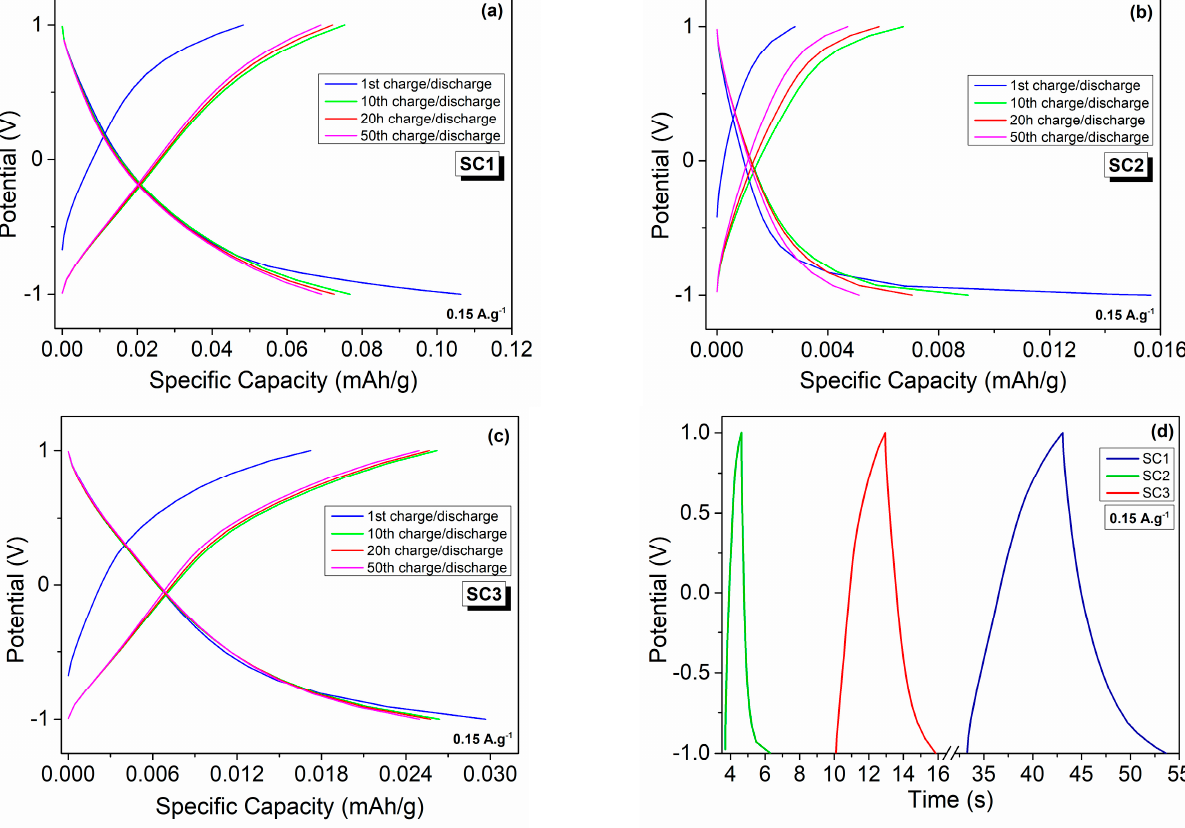
Figure 10. Galvanostatic charge–discharge profiles of the symmetric and asymmetric all-in-one SCs at a current density of 0.15 A.g − 1 : 1st, 10th, 20th, and 50th charge–discharge cycles of ( a ) SC1, ( b ) SC2, and ( c ) SC3; ( d ) 1st cycle charge–discharge curves of the fabricated SCs. Table 2. Summary of the electrochemical performance of the fabricated symmetric and asymmetric supercapacitor devices. The cycling stability, specific capacitance and specific capacity were cal- culated after 50 cycles at a current density of 0.15 A.g − 1 .